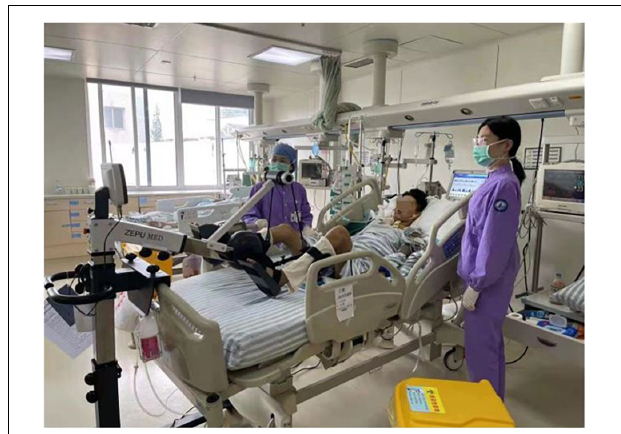
FIGURE 1 | Bedside cycle ergometer (Shandong ZEPU Medical Technology Company,